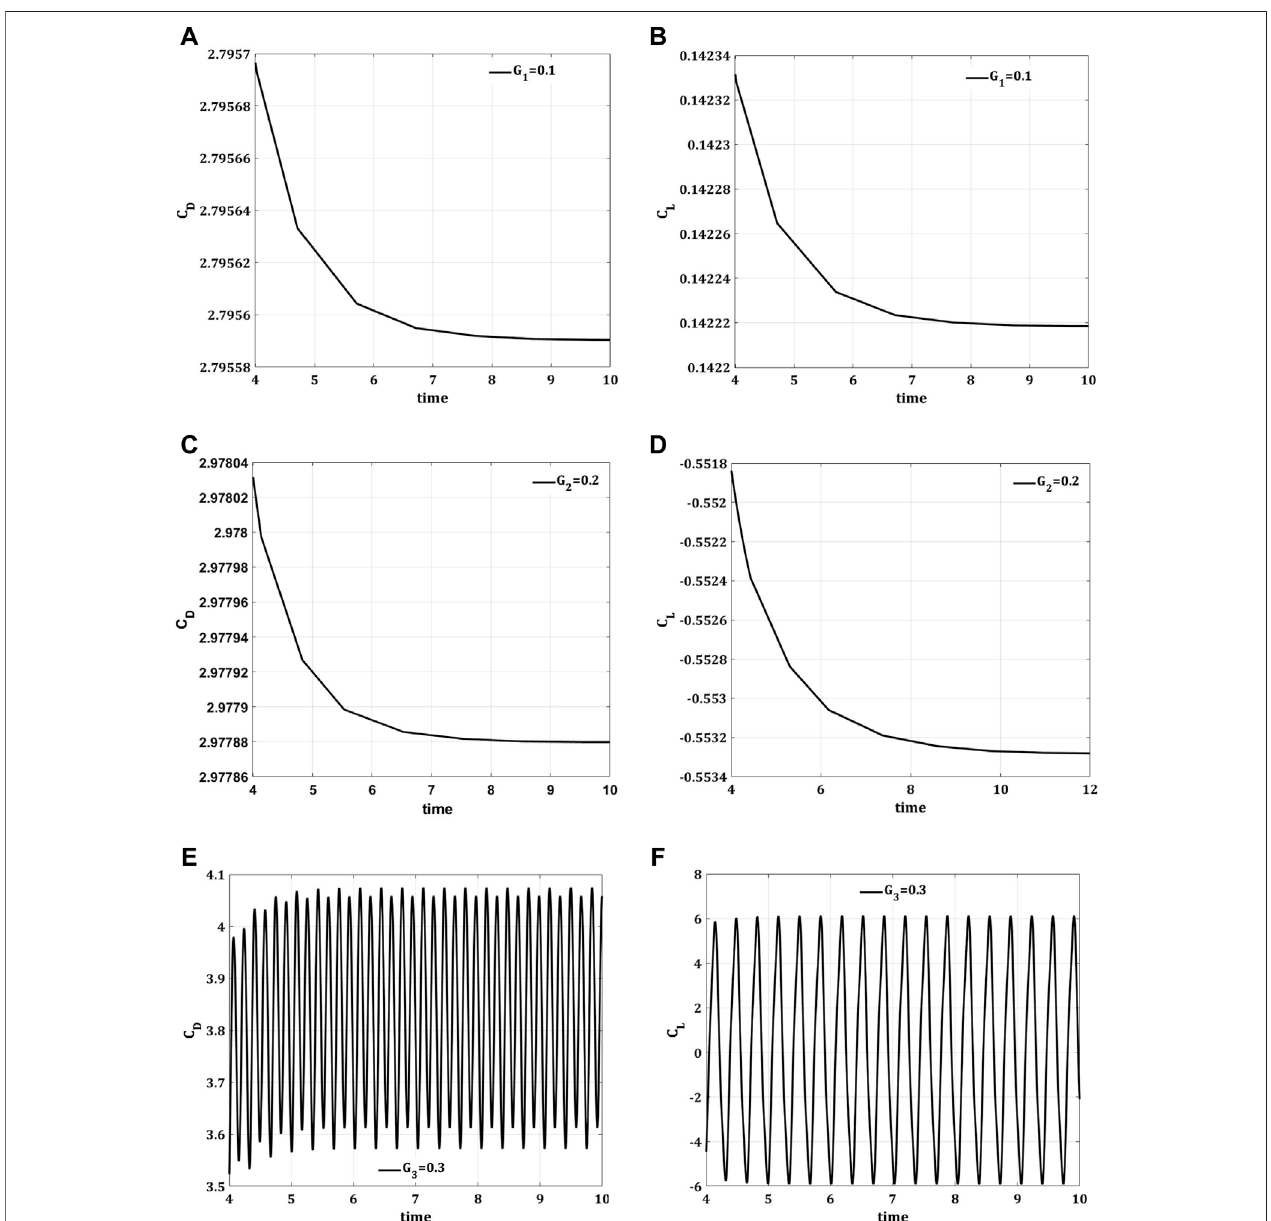
FIGURE10| Impactofsplitterplatewithvariousgapseparations (A,B) G 1 =0.1, (C,D) G 2 =0.2, (E,F) G 3 =0.3ondrag coef fi cient(C D )andliftcoef fi cient(C L ),w.r.t time ( (cid:2) t ) , step size Δ t = 0.001.